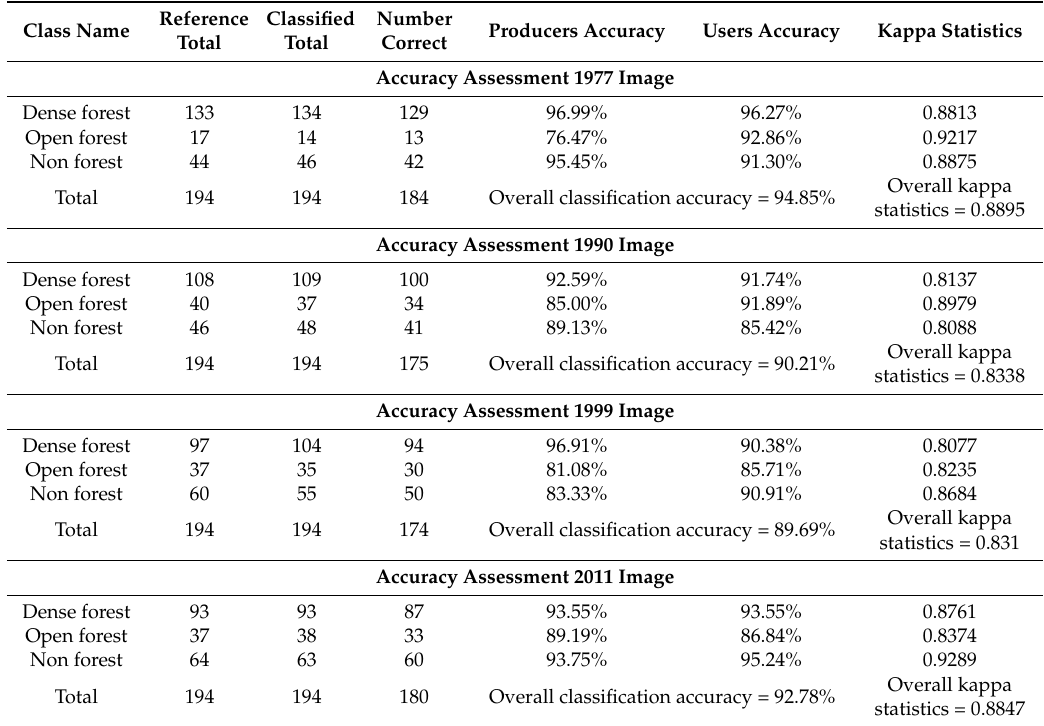
Table 4. Accuracy assessment of classified